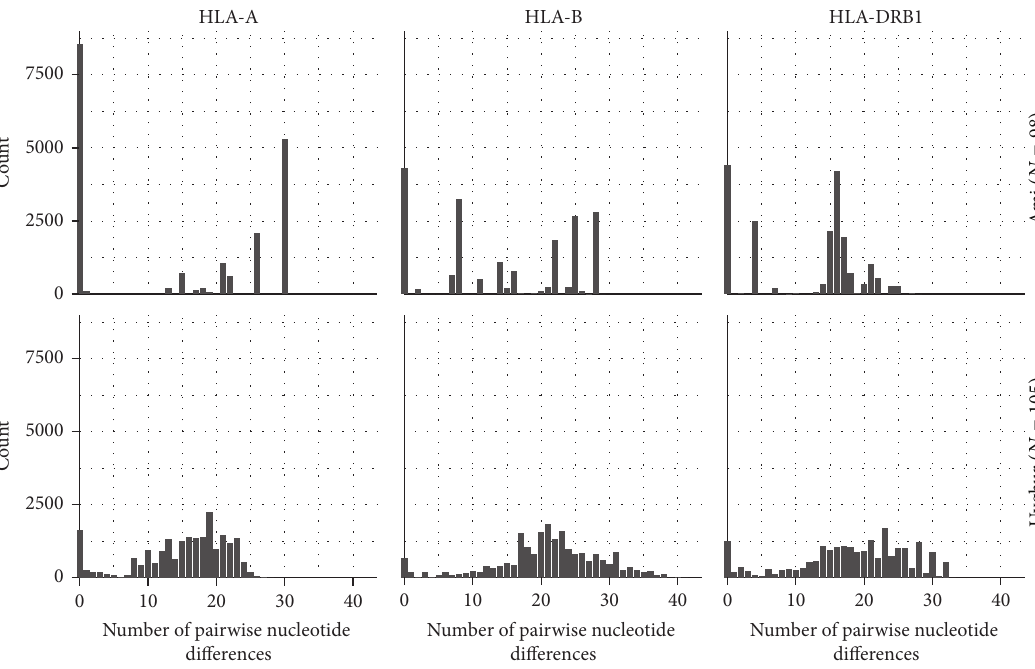
Figure 2: Distributions of the number of nucleotide differences between pairs of sequences (mismatch distributions) in two Asiatic populations of close sample sizes, one Taiwanese (Ami, 𝑁 = 98 , top) and one continental (Uyghur, 𝑁 = 105 , bottom), based on DNA sequences of HLA -A, HLA -B, and HLA -DRB1 alleles defined at high resolution (sequences downloaded from IMGT/HLA database). While the distributions exhibit a likely unimodal shape for the Uyghur, suggesting recent demographic expansion, they are very irregular for the Ami, reflecting population stationarity or contraction (note that the zero class corresponds to identical sequences, reflecting a high proportion of homozygosity). Besides these demographic signatures, Tajima’s 𝐷 are positive for all distributions, in agreement with balancing selection acting on these loci (not